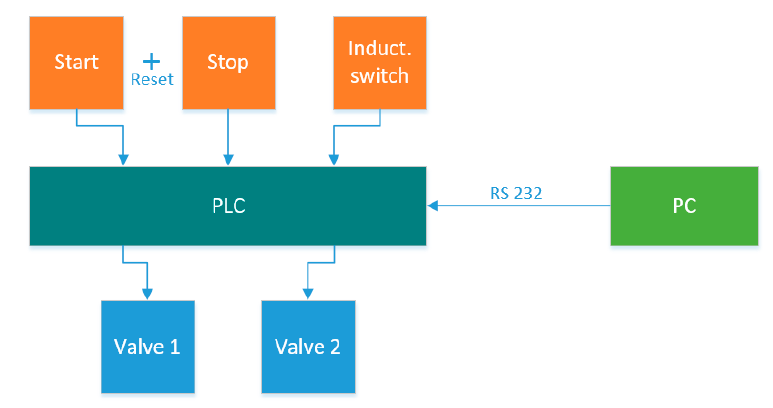
Figure 8. Block diagram of the control system of the fatigue test rig.